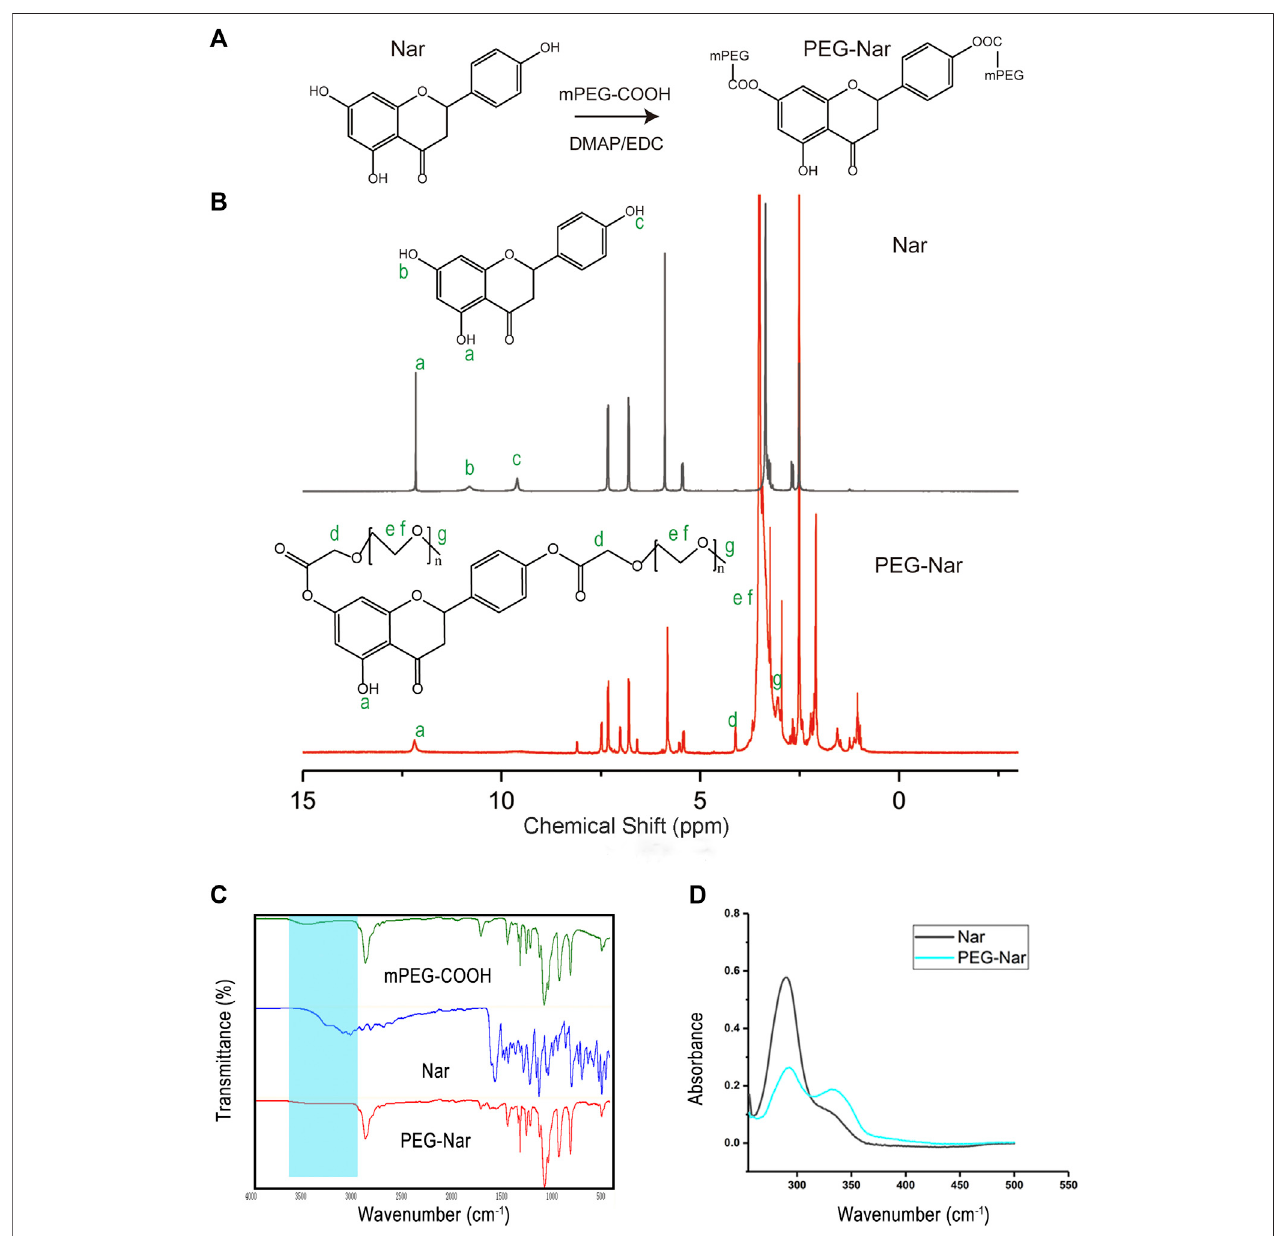
FIGURE2| SynthesisandcharacterizationofPEG-Nar. (A) SyntheticrouteofPEG-Nar. (B) 1Hnuclearmagneticresonancespectroscopy(NMR)ofPEG-Nar. (C) FTIR spectra of PEG-Nar and raw materials. (D) UV spectra of PEG-Nar and Nar.